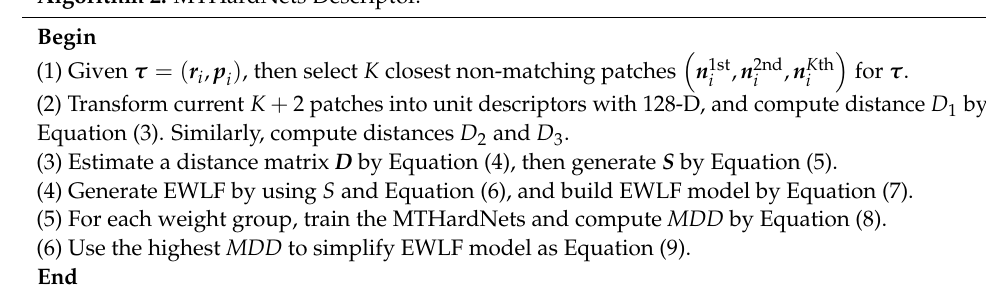
Algorithm 2. MTHardNets Descriptor.